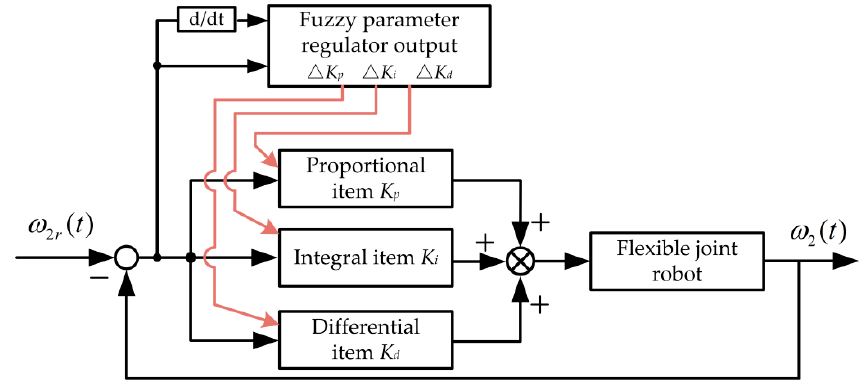
Figure 6. Structure of the fuzzy PID controller for the flexible-joint robot system.